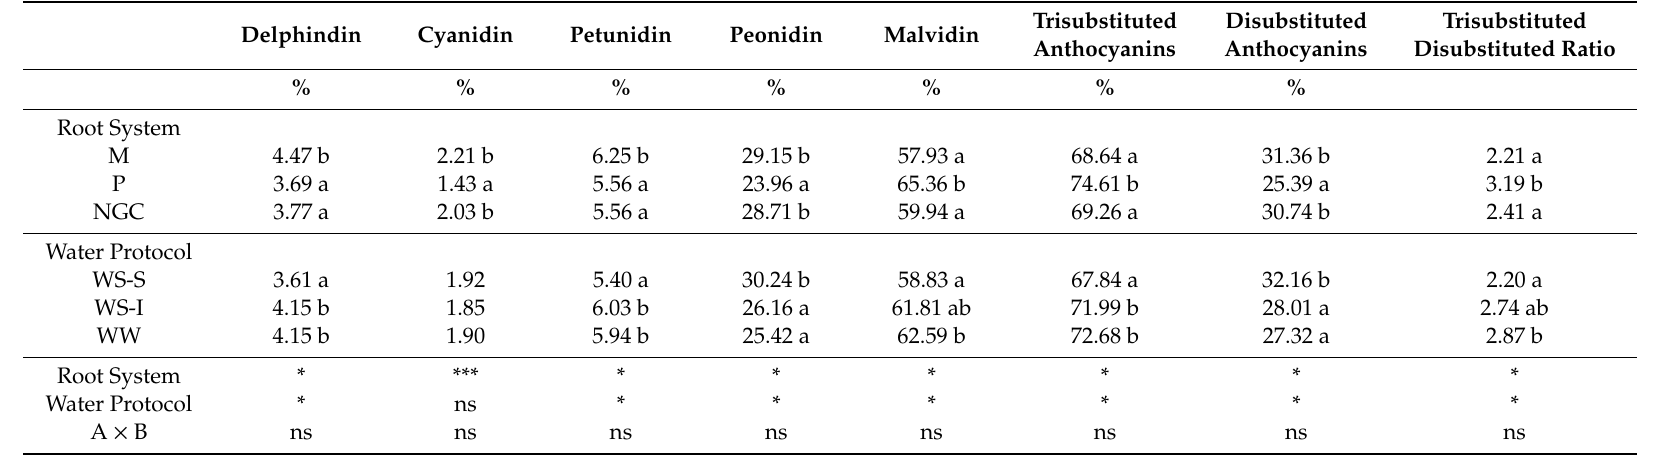
Table 3. Anthocyanin profiles by HPLC of berry skins of Pinot noir vines grafted on Mgt 101-14 (M), 1103 Paulsen (P), and not grafted vines (NGC), treated with three irrigations protocols (WS-S, WS-I, and WW). Data were subjected to two-way ANOVA: *, ***, ns indicate significant di ff erences at P < 0.05, 0.001, or not significant. Within root system and water protocol, di ff erent letters indicate significant di ff erences (Bonferroni test, P <